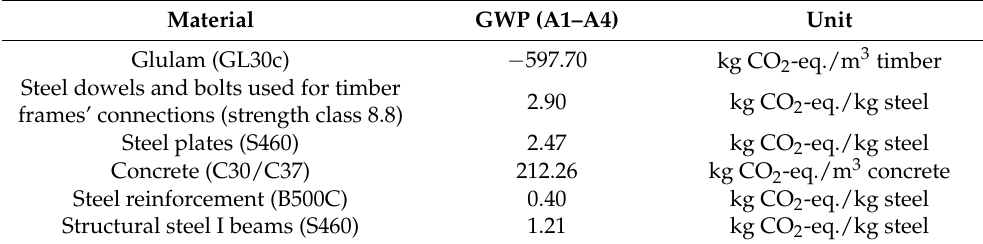
Table 5. Summary of the GWP for different material [34].